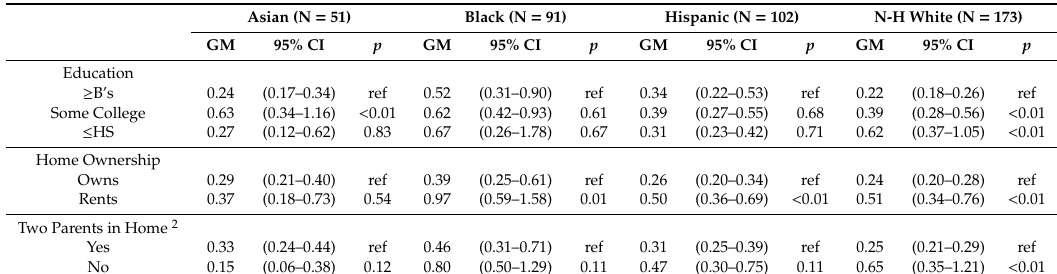
Table 3. Demographic and Household Characteristics Predicting Urinary Cotinine ( µ g / g creatinine) Geometric Means 1 , by Race /